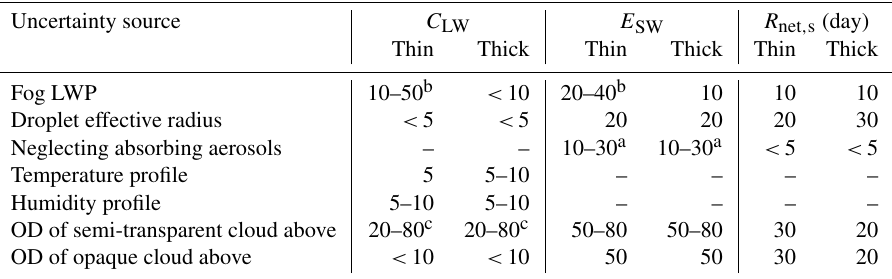
Table 3. Rough estimates of the relative uncertainty (in % of the estimated value) of each radiation parameter (defined in Sect. 2.1) due to various sources of uncertainty, for thin (LWP < ≈ 30gm − 2 ) and thick (LWP > 30gm − 2 ) fog. The last two rows are relevant when an opaque or semi-transparent cloud overlies the fog. See text for details.